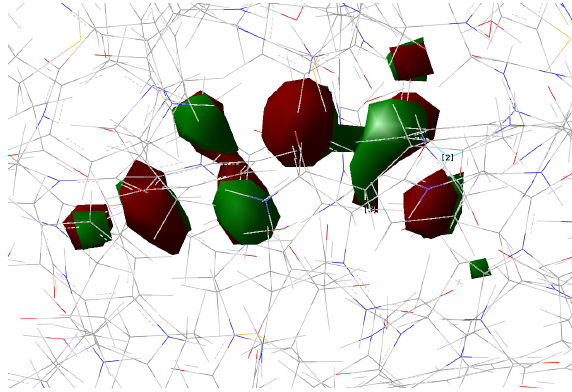
Figure 13. LUMO calculated for psamFP488 in Network2.